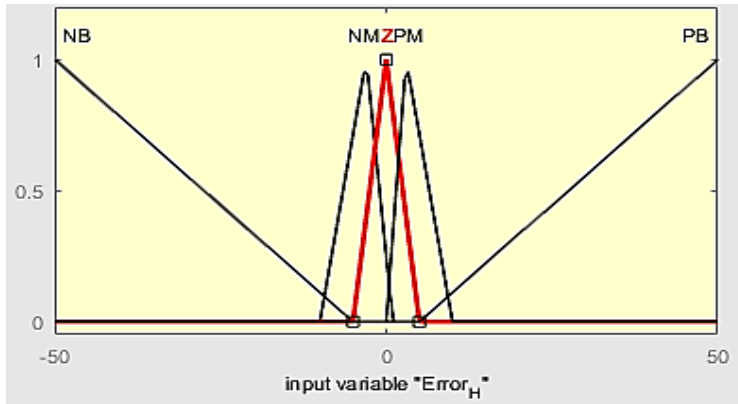
Figure 12. Membership functions of the humidity error.